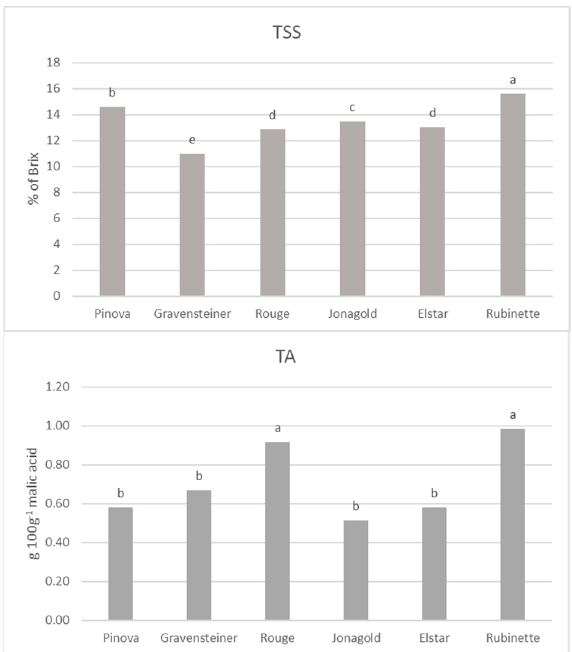
Figure 2. Total soluble solids (TSS) ( 2a ) and Titratable acidity (TA) ( 2b ) values of apple juice samples. Different lower-case letters (a–d) show significant differences among treatments ( p -value ≤ 0.05). Table 1. Ratio total soluble solids / titratable acidity and BrimA values of apple juice samples and their relative rank, in descending order. Ratio TSS/TA